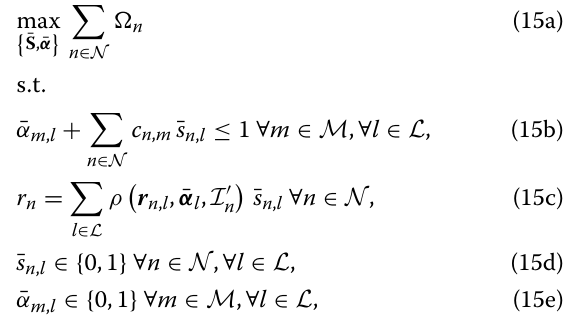
(cid:6) (cid:5) for UE n , on PRB l r n , l , ¯ α l , I (cid:4) n